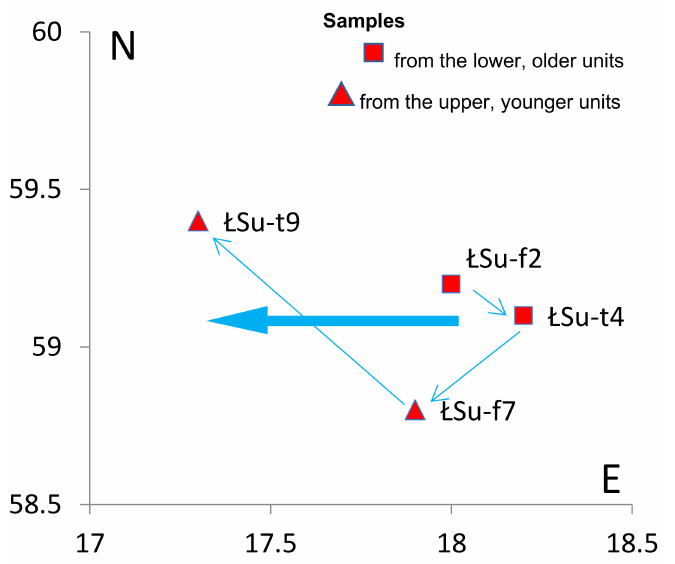
Figure 10. Theoretical boulder centres of indicator erratics from Łubienica-Superunki. The ar- rows show the shift of TCBs from the younger layer towards the upper one. The resultant shift is also